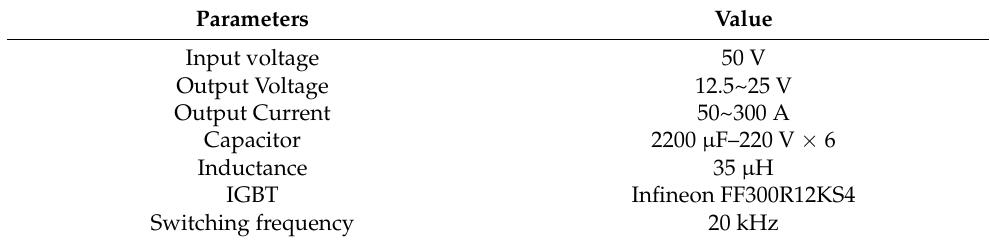
Table 1. Experimental